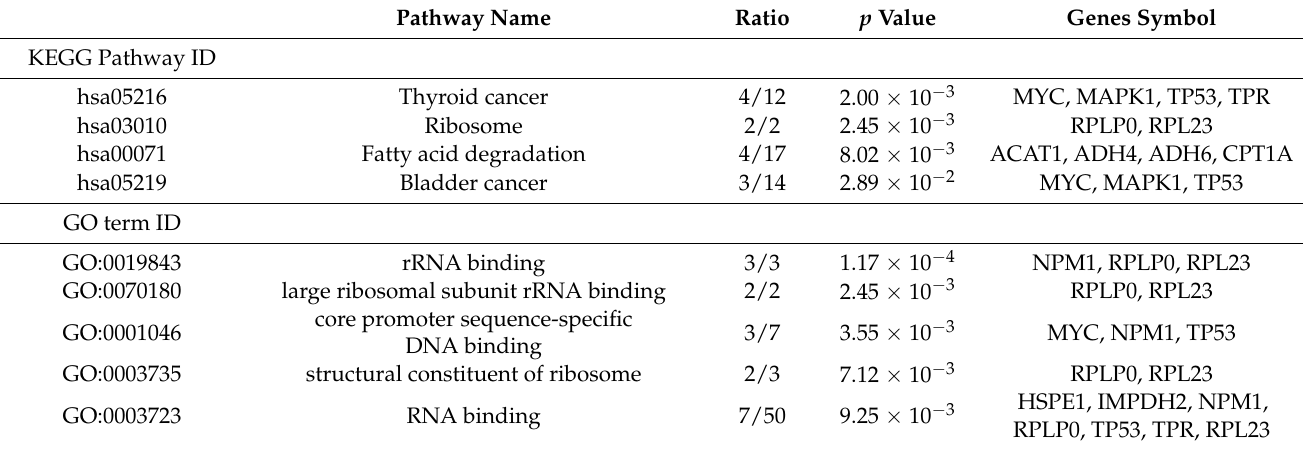
Table 2. Enriched KEGG pathways and top 5 GO terms before intervention.